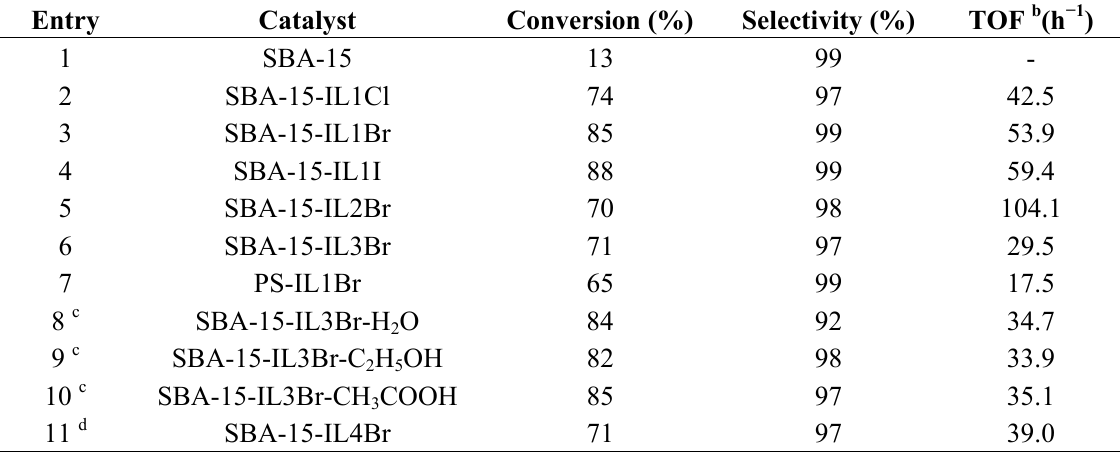
Table 10. Synthesis of PC catalyzed by SBA-15 supported1,2,4-triazolium-based ILs a